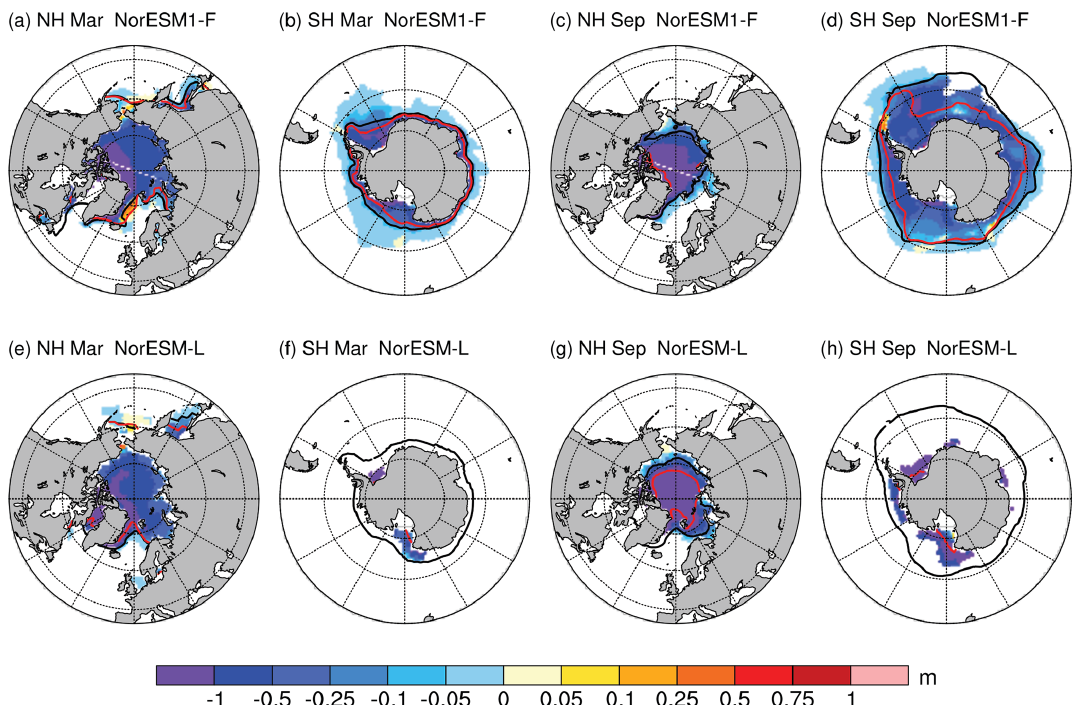
Figure 5. The difference in climatological sea ice thickness (shading; units: m) between the Pliocene and preindustrial experiments according to NorESM1-F (a, b, c, d) and NorESM-L (e, f, g, h) for March (a, b, e, f) and September (c, d, g, h) . The red and black lines represent 15 % sea ice concentration in the Pliocene and preindustrial experiments, respectively.